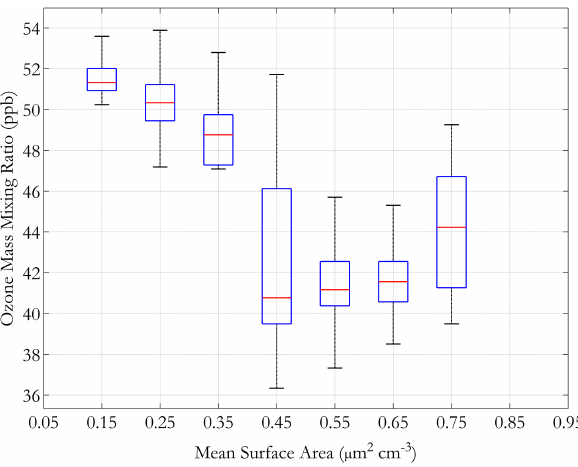
Figure 9. Box and whisker diagram of mineral dust mean surface area and ozone mass mixing ratio along the b707 (15 June 2012) flight transect. Surface area is calculated from PCASP count median